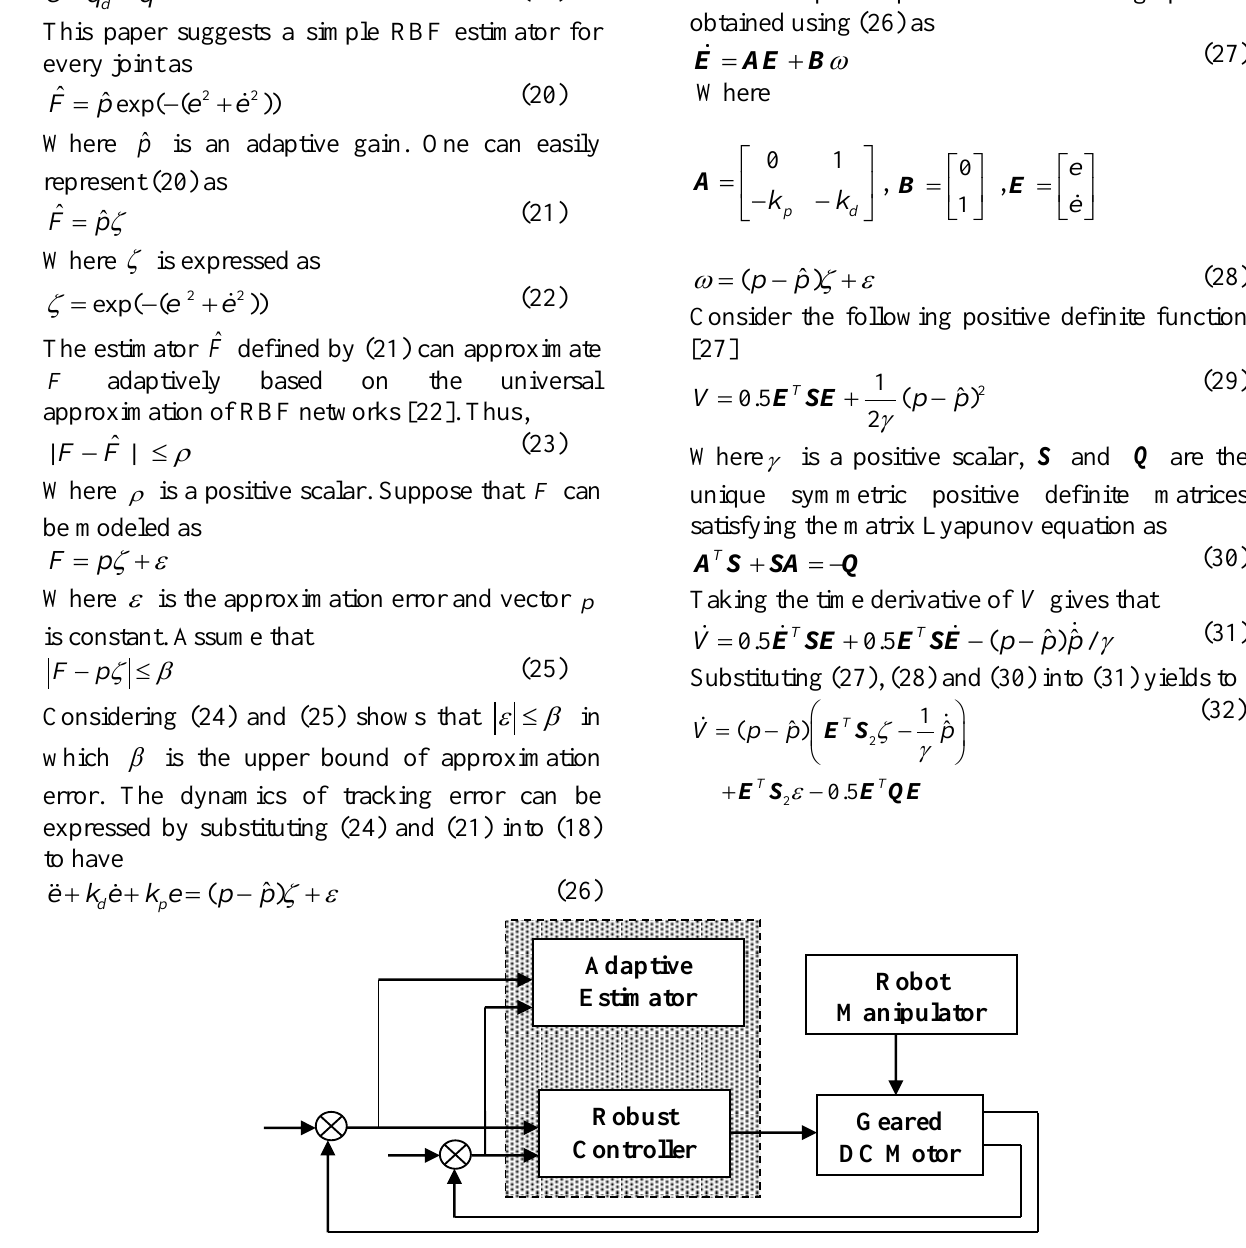
Figure 1. Proposed robust RBF network